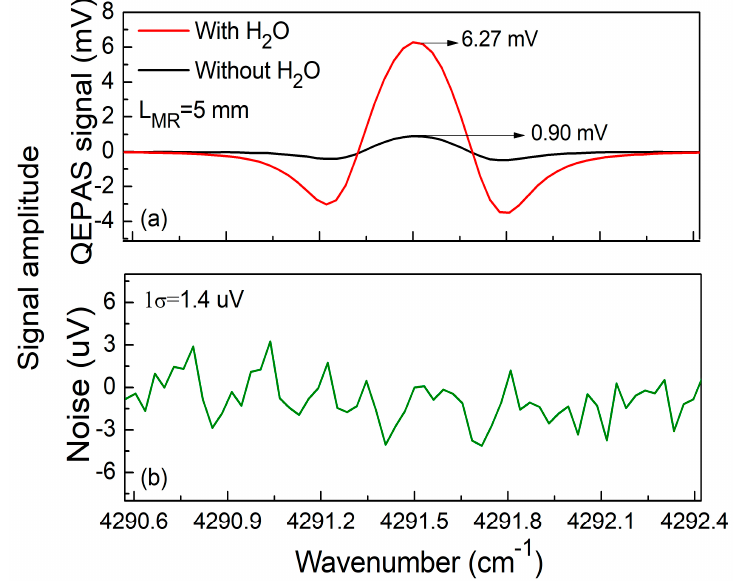
Figure 6. Signal amplitude. ( a ) QEPAS signal based on a 5 mm MR with and without H 2 O; ( b ) Pure N 2 for a noise background determination.